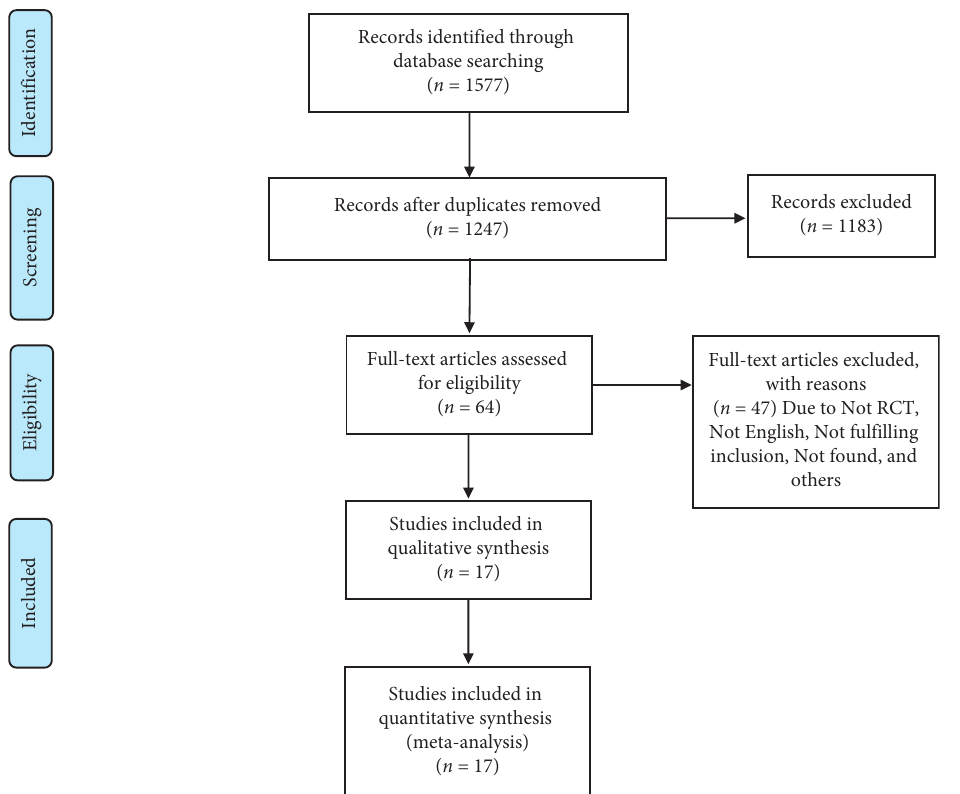
Figure 1: Flowchart for study